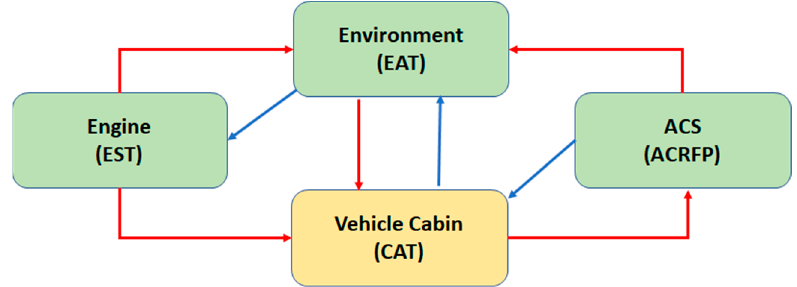
Figure 1. Heat exchange: Vehicle interactive elements.